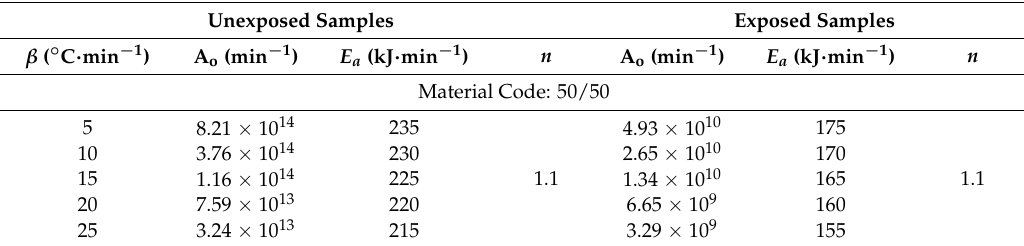
Table 2. Apparent activation energy ( E a ), pre-exponential factor (A o ), and reaction order ( n ) results determined using the developed analytical solution mathematical